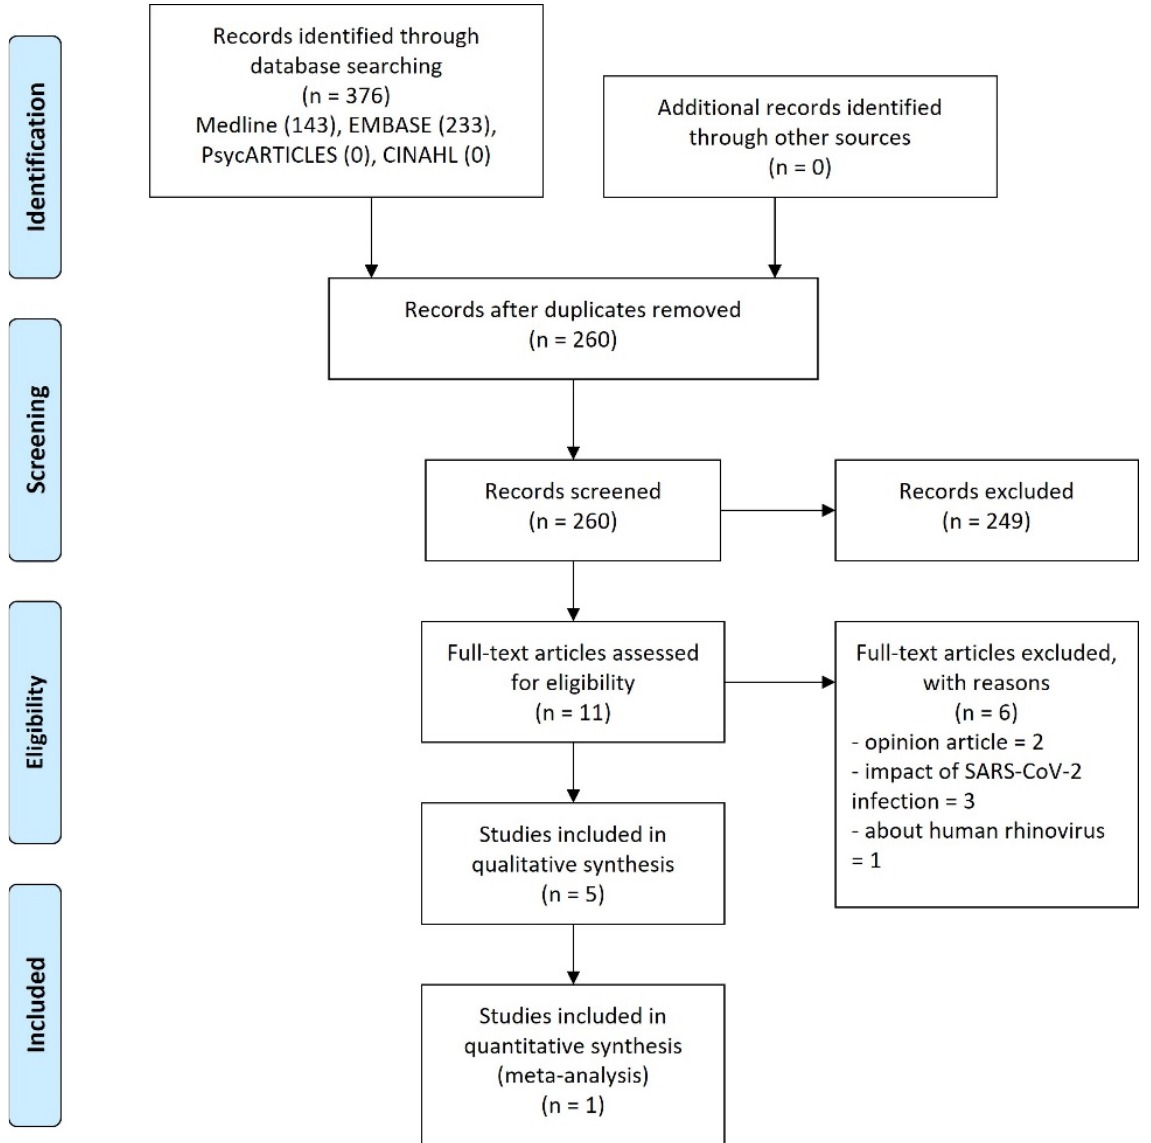
Figure 1. PRISMA flow diagram of this review. Abbreviations. CINAHL, Cumulative Index to Nursing and Allied Health Literature; SARS-CoV-2, severe acute respiratory syndrome coronavirus 2.